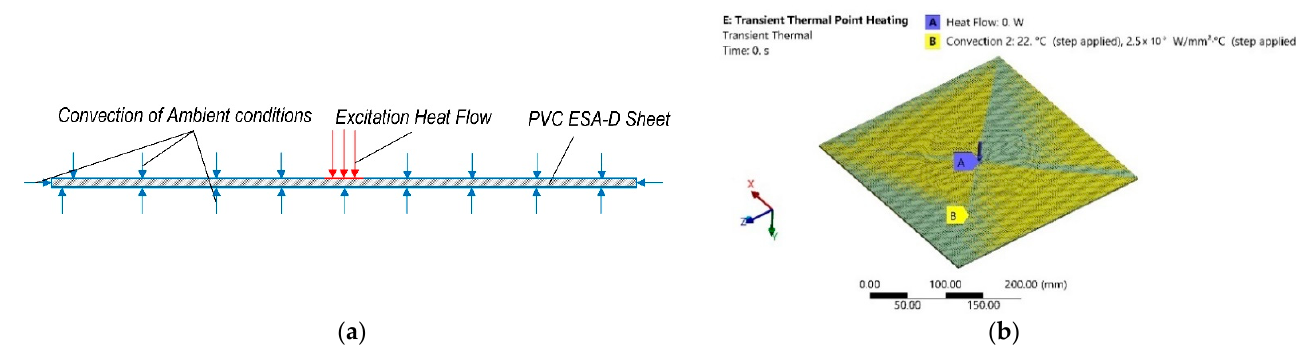
Figure 10. Transient thermal numerical analysis: ( a ) scheme; ( b ) computational model with boundary conditions. Table 5. FE numerical simulation data of the first stage of analysis.